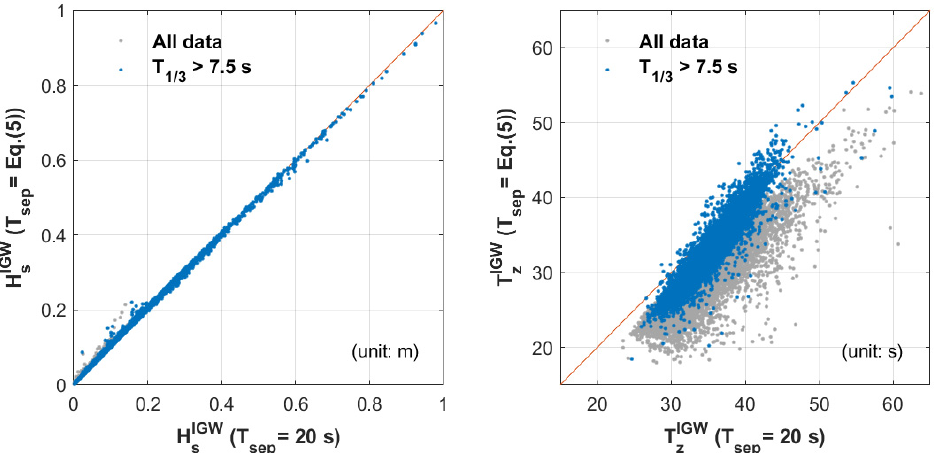
Figure 7. Comparison of the wave heights and periods of the infragravity waves that are calculated by using the separation frequency of the suggested method and a fixed value of 20 s.